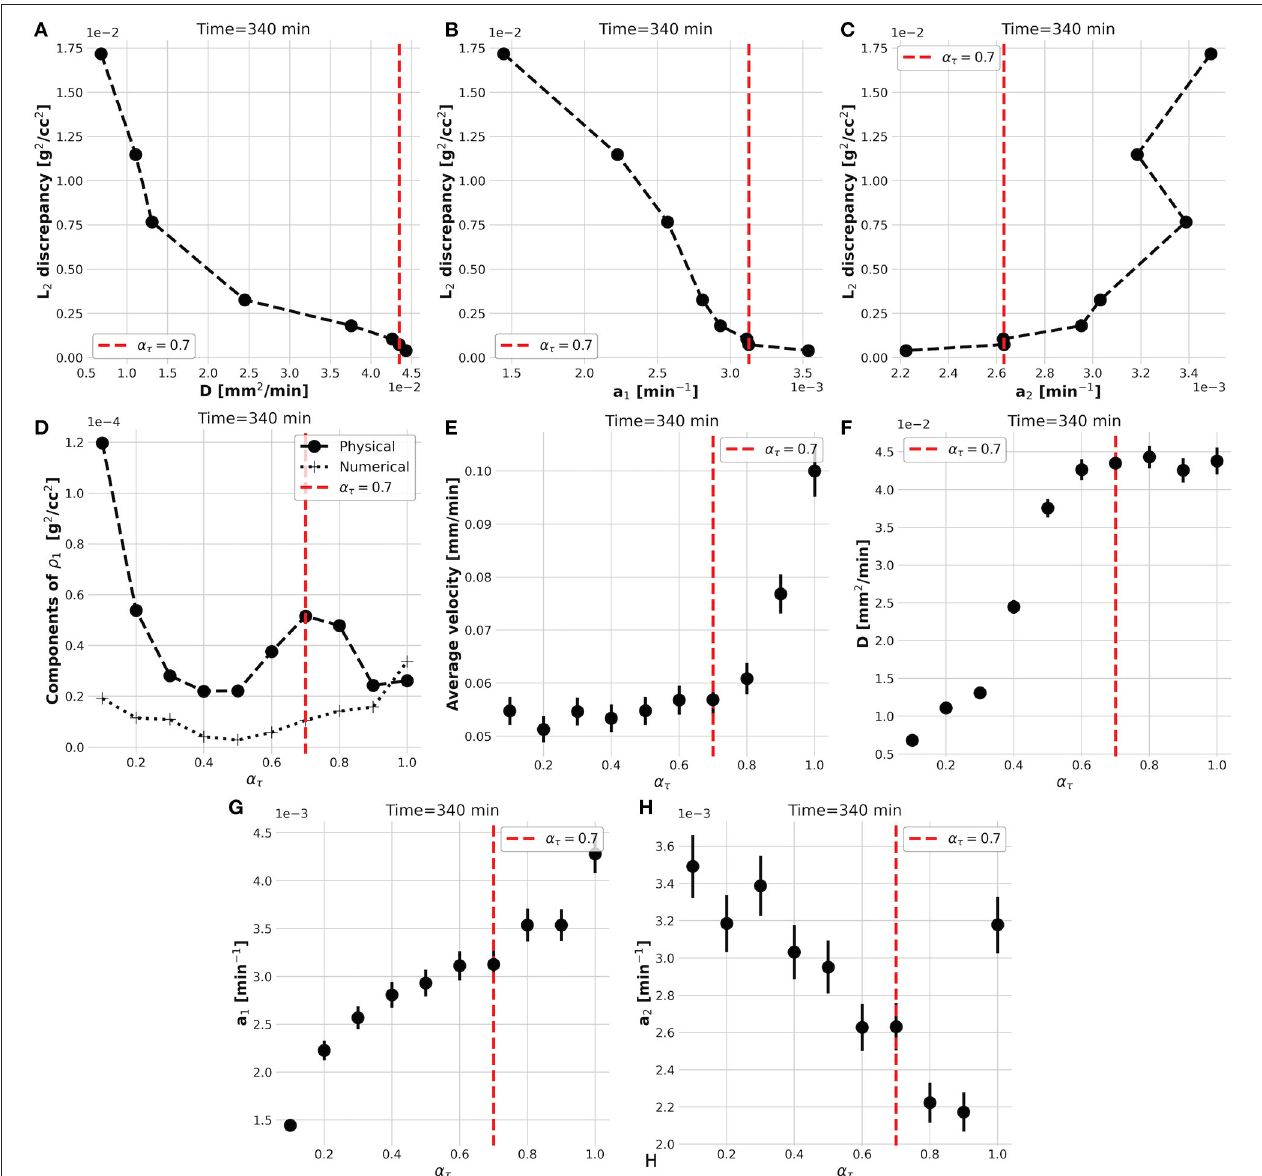
FIGURE 5 | The L-shaped functional dependence between L 2 discrepancy and estimated parameters at different α τ (A–C) , impacts the strength of the physical and numerical dissipative components of the KC-DA procedure (D) . The knee/elbow point of the L 2 discrepancy at α τ = 0.7 (red dotted line) identifies the best estimation of the parameters, which corresponds to a plateau region (E–H)